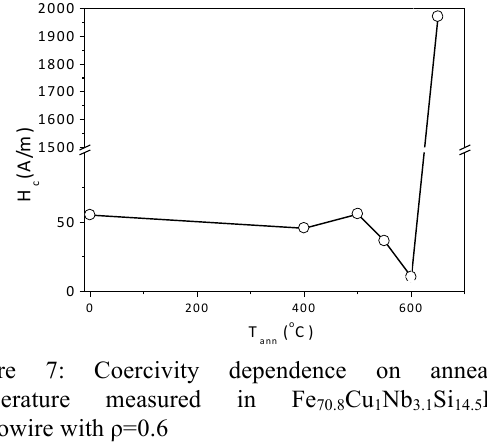
Cu Nb Si B 70.8 1 3.1 14.5 10.6